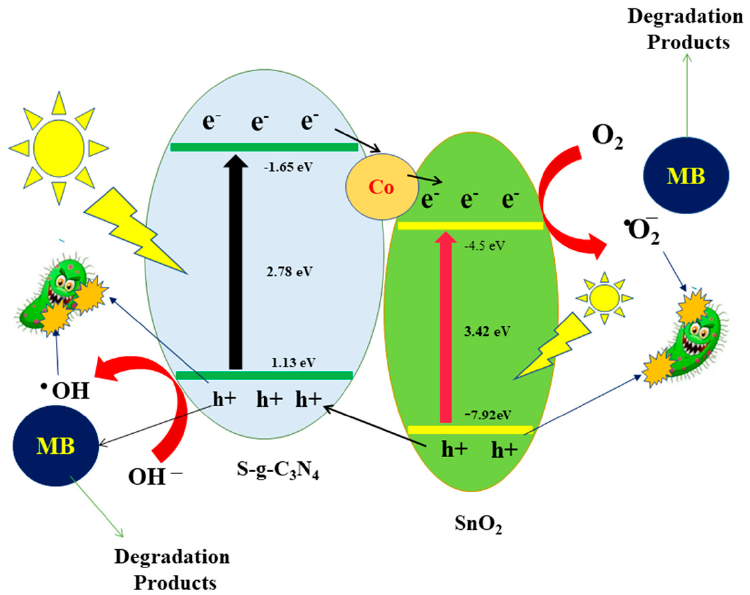
Figure 11. An illustration of the catalytic degradation mechanism of MB under sunlight over the Co-SnO 2 /S-g-C 3 N 4 NCs.